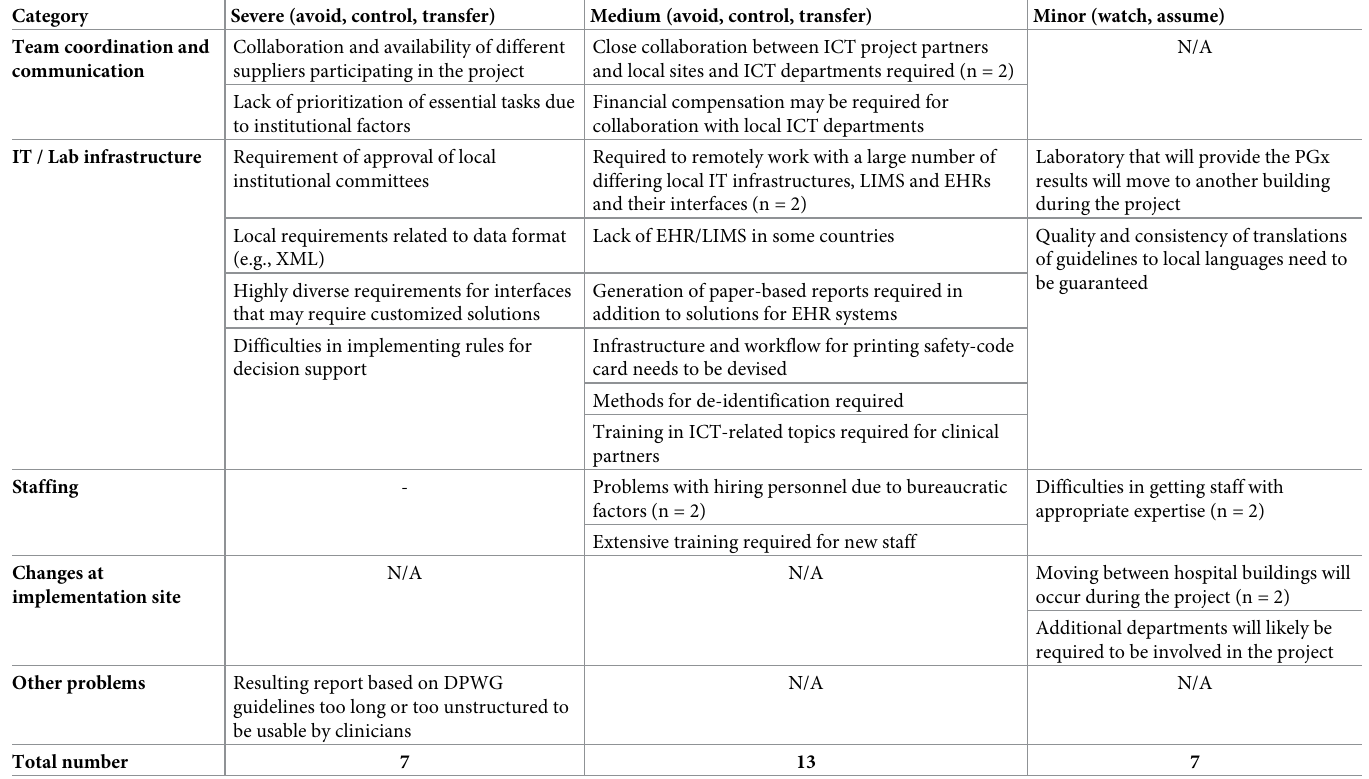
Table 1. Identified risks per thematic category and severity rating. LIMS: Laboratory information management system.